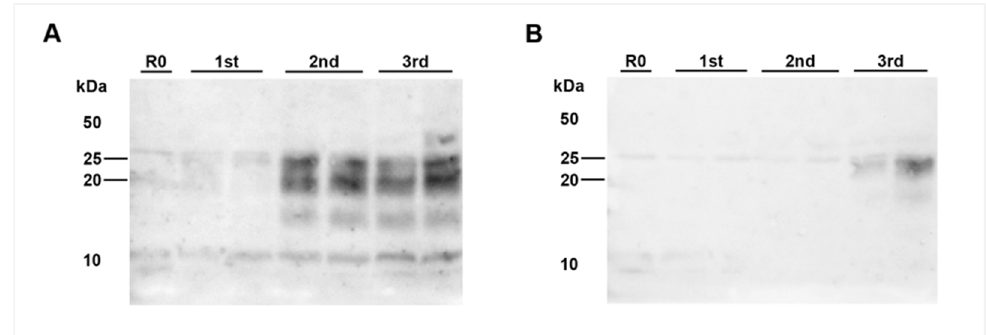
Figure 3. PrP BSE amplification by PMCA in the thoracic spinal cord from a calf at 8 months after challenge. PMCA detected PrP BSE in the thoracic spinal cord segment T7 of IC 02 (8 mpi); ( A ): (+)++ positive PMCA reaction for the homogenate used for inoculation of bioassay mice; ( B ): analyzing a different location of the same T7 sample revealed amplification only in the third round (+ positive reaction); each sample was analyzed in duplicate and subjected to 3 rounds of PMCA. M: marker, R0: analyte homogenate diluted 1:10 in Tgbov XV brain substrate without sonication. Table 3. Results obtained for samples of the central nervous system together with the clinical status of all challenged calves. Time Point Obex Cranial Medulla Frontal Cortex Animal Infection Post Inoculation ID Status